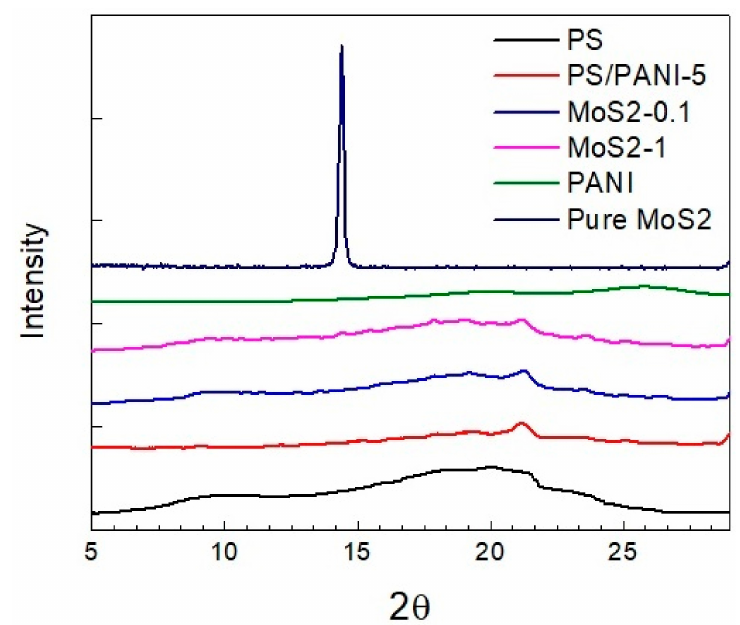
Figure 3. X-ray di ff raction of PS, PANI, PS / PANI-5 wt % polymer blend and PS / PANI / MoS 2 hybrid polymer composites with varying concentration of MoS 2